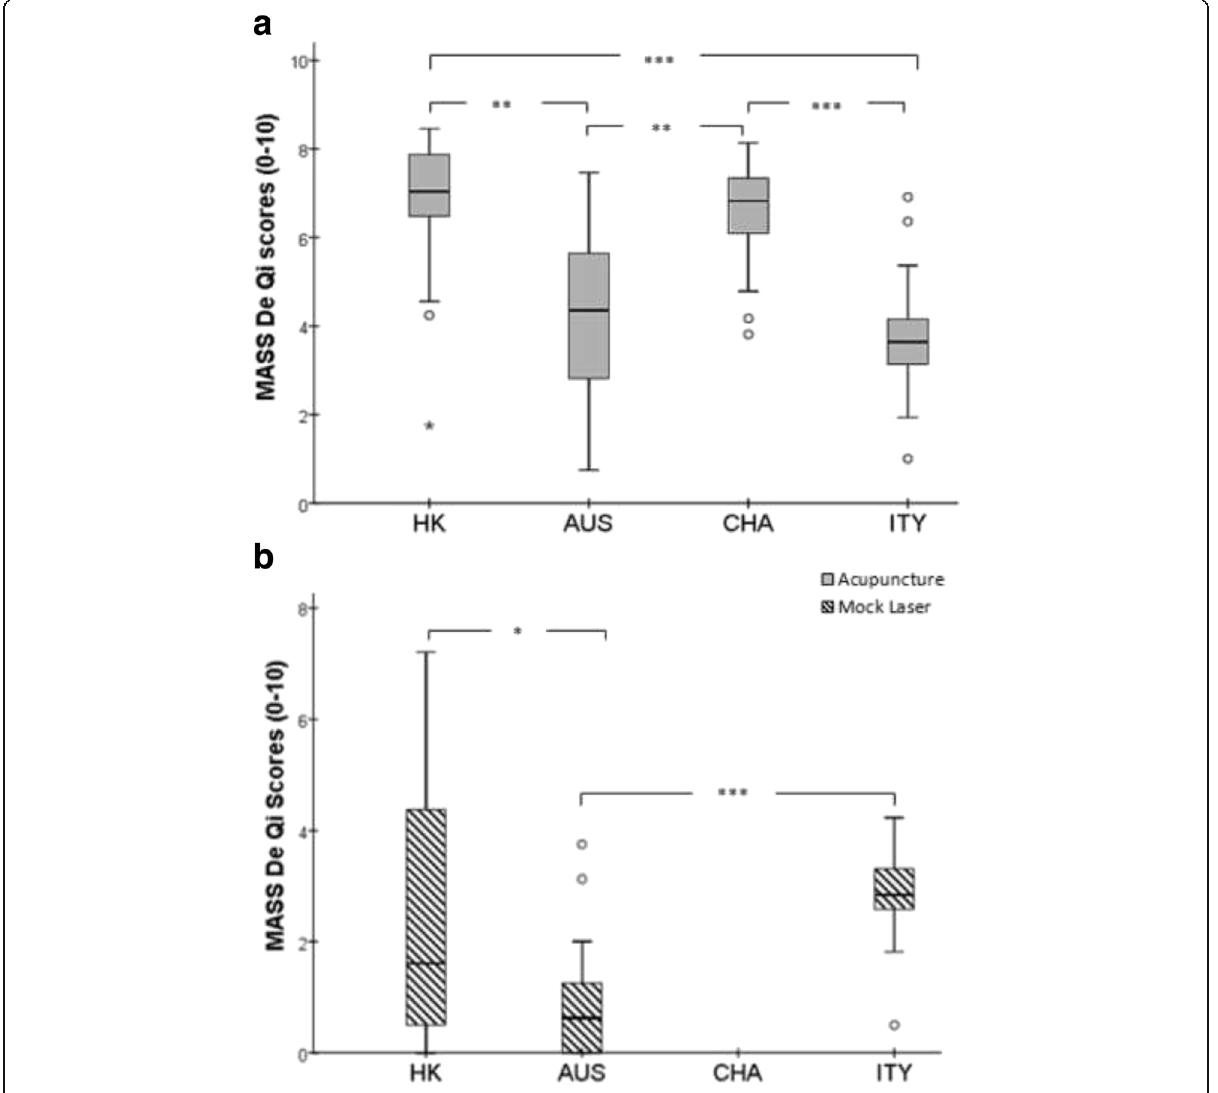
demonstrate comparison of the MASS De Qi median scores between the four trial sites for both the acupuncture group (HK = 22, AUS = 24, CHA = 24, ITY = 24) and the mock laser group (HK = 26, AUS = 24, ITY = 24). One trial site (China) did not collect data for the mock laser group. Bonferroni correction for multiple comparisons was used. Pairwise comparison demonstrated statistically significant differences in the MDI scores across different trial sites (Kruskal-Wallis Rank Sum test, * p < 0.05, ** p < 0.01, *** p < 0.001; 2-tailed). Extreme values and outliers lied beyond the whiskers and denoted differently with a star and a circle